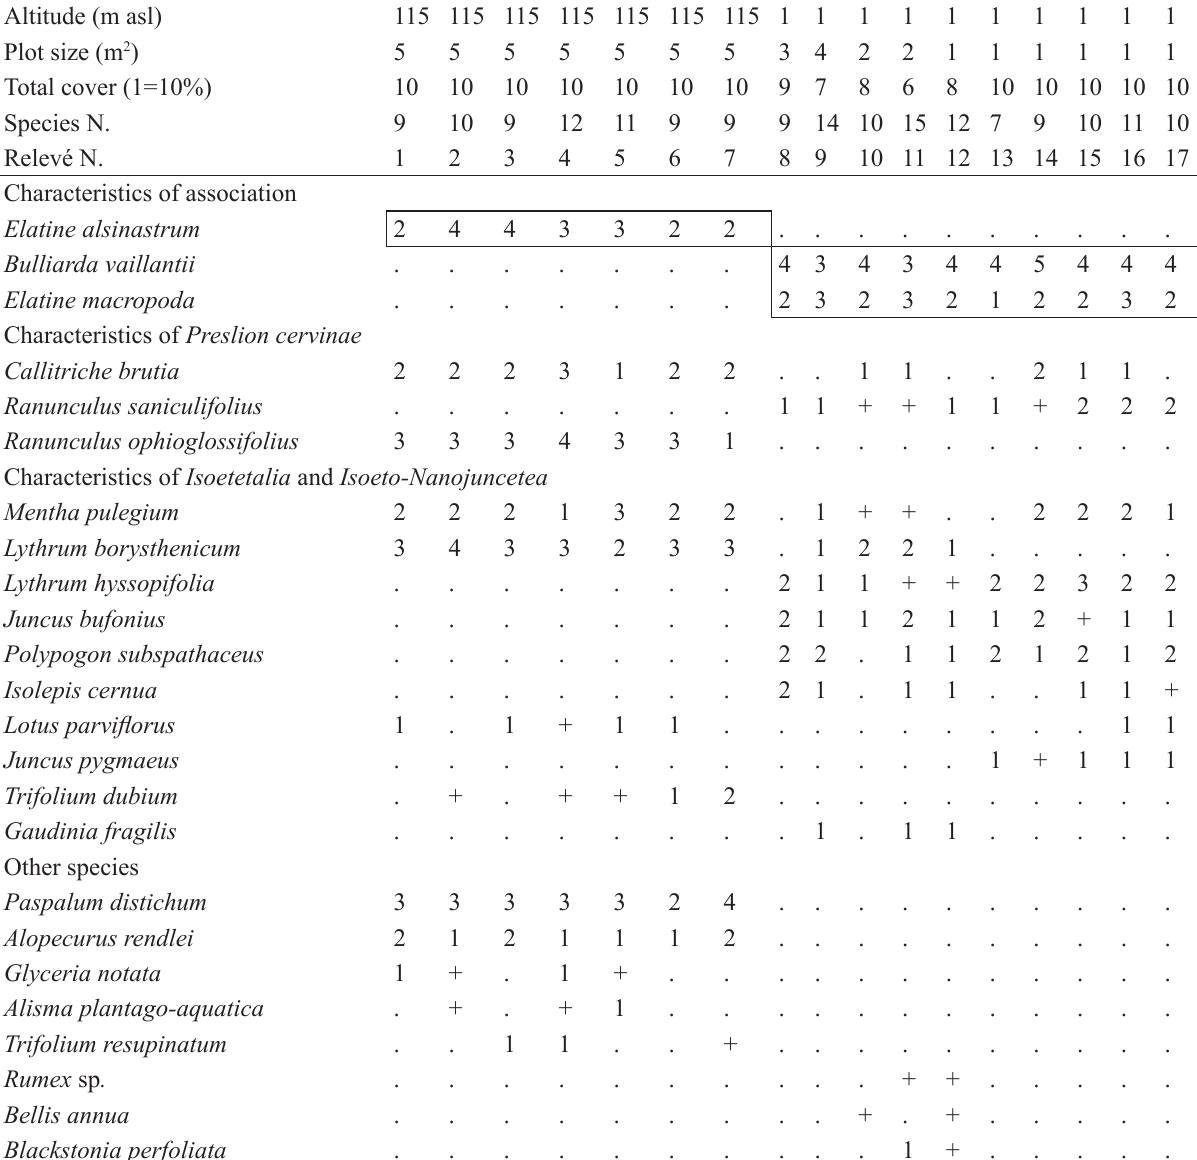
Table 3. Ranunculo ophioglossifolii-Elatinetum alsinastri ass. nova (rel. 1-7), Ranunculo saniculifolii-Elatinetum macropodae ass. nova (rel. 8-17) ( Preslion cervinae , Isoetetalia , Isoeto-Nanojuncetea ) Altitude (m asl) Total cover (1=10%) Species N. Relevé